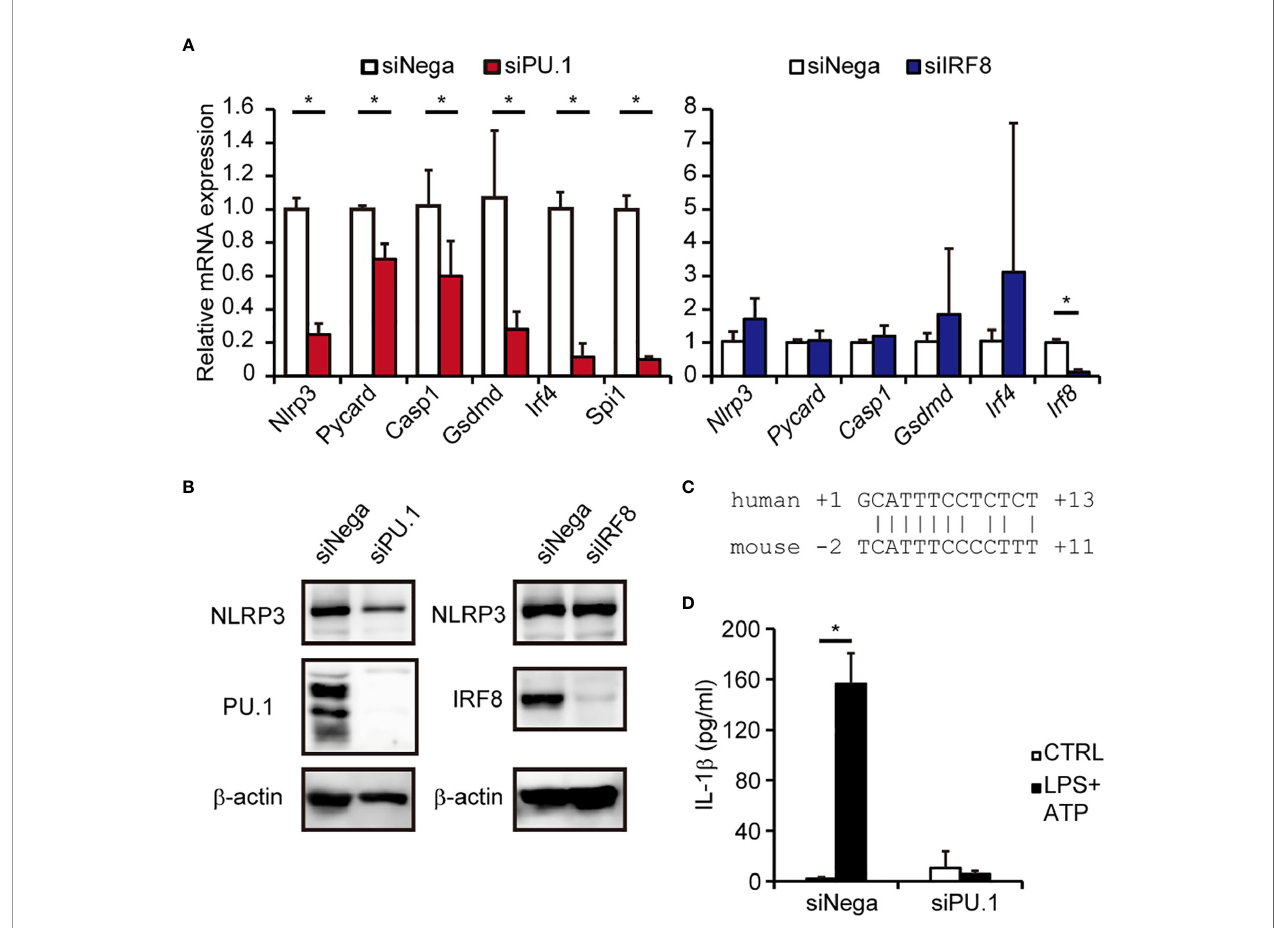
FIGURE 6 | Effects of PU.1 and IRF8 knockdown on NLRP3 expression and activation of the NLRP3 in fl ammasome in mouse macrophages. (A, B, D) BMDMs were transfected with Spi1 siRNA (siPU.1), Irf8 siRNA (siIRF8), or negative control siRNA (siNega) and incubated for 48 h. (A) Relative mRNA expression was determined by qPCR and normalized to Gapdh mRNA expression. (B) Cellular protein expression was determined by western blotting. (D) Cells were primed with 1 m g/mL LPS for 4 h and then stimulated with 2 mM ATP for 0.5 h. The amount of IL-1 b in the culture medium was measured by ELISA. (C) Comparison of human and mouse sequences around the Ets motif. Data are presented as the mean + S.D. ( n = 3). (A) * p < 0.05, two-tailed student ’ s t -test analysis. (D) * p < 0.05, Tukey – Kramer